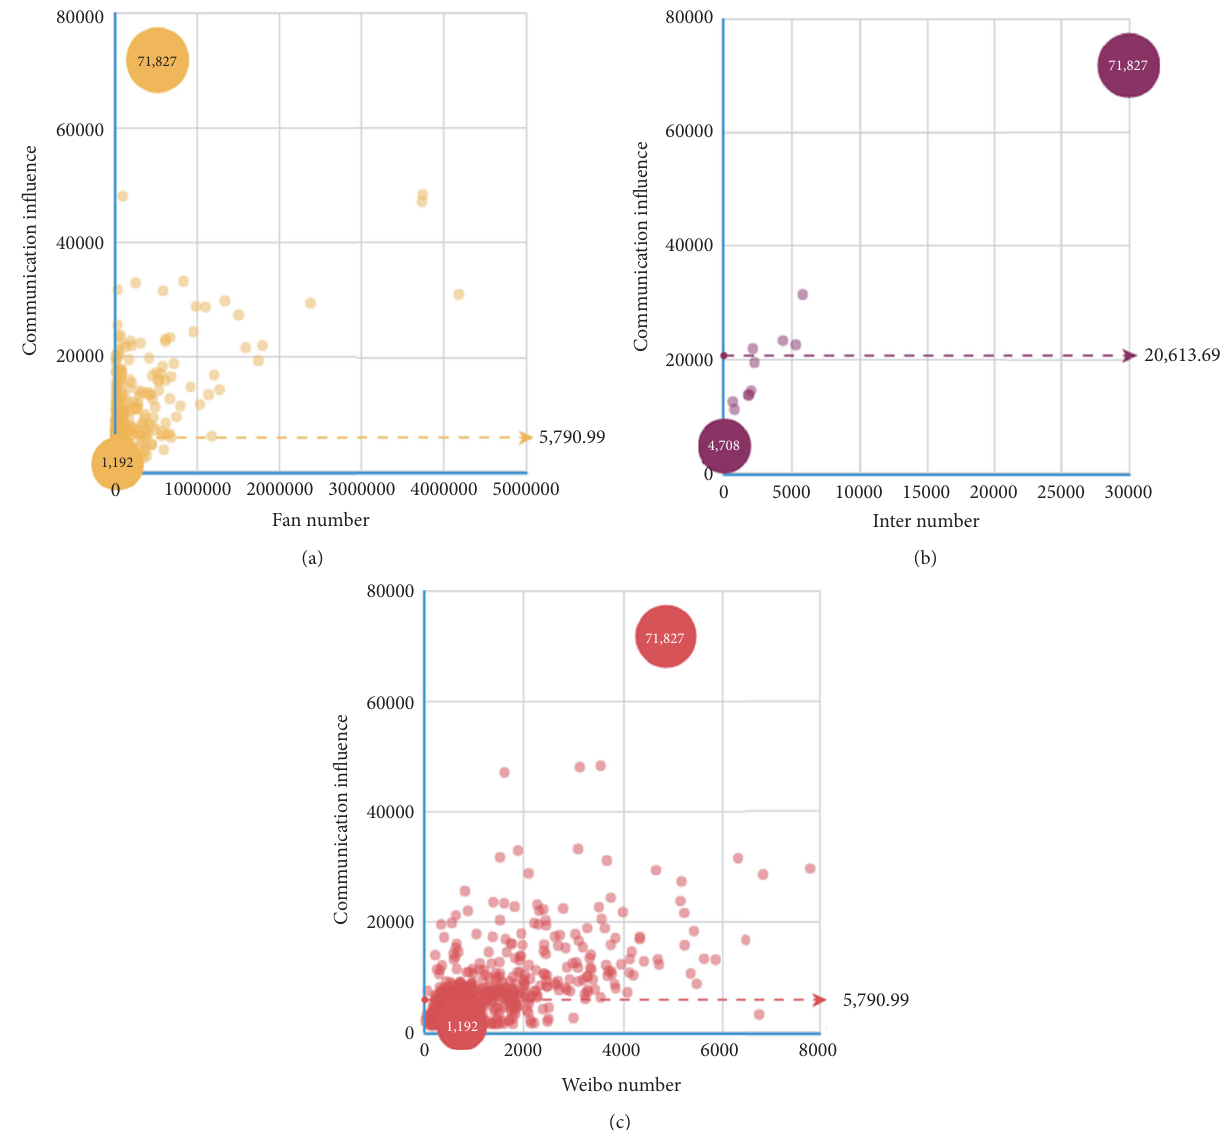
Figure 2: Influential factors of government affairs microblogs’ communication